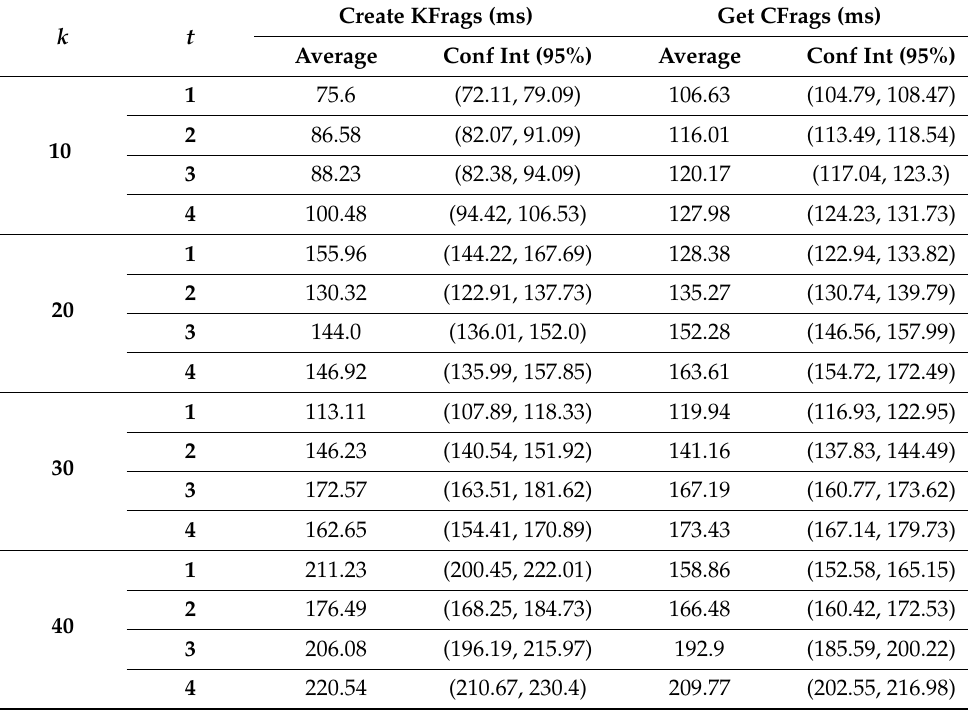
Table 3. Average response latency and confidence interval for the Create KFrags and Get CFrags operations in a round, varying t and k